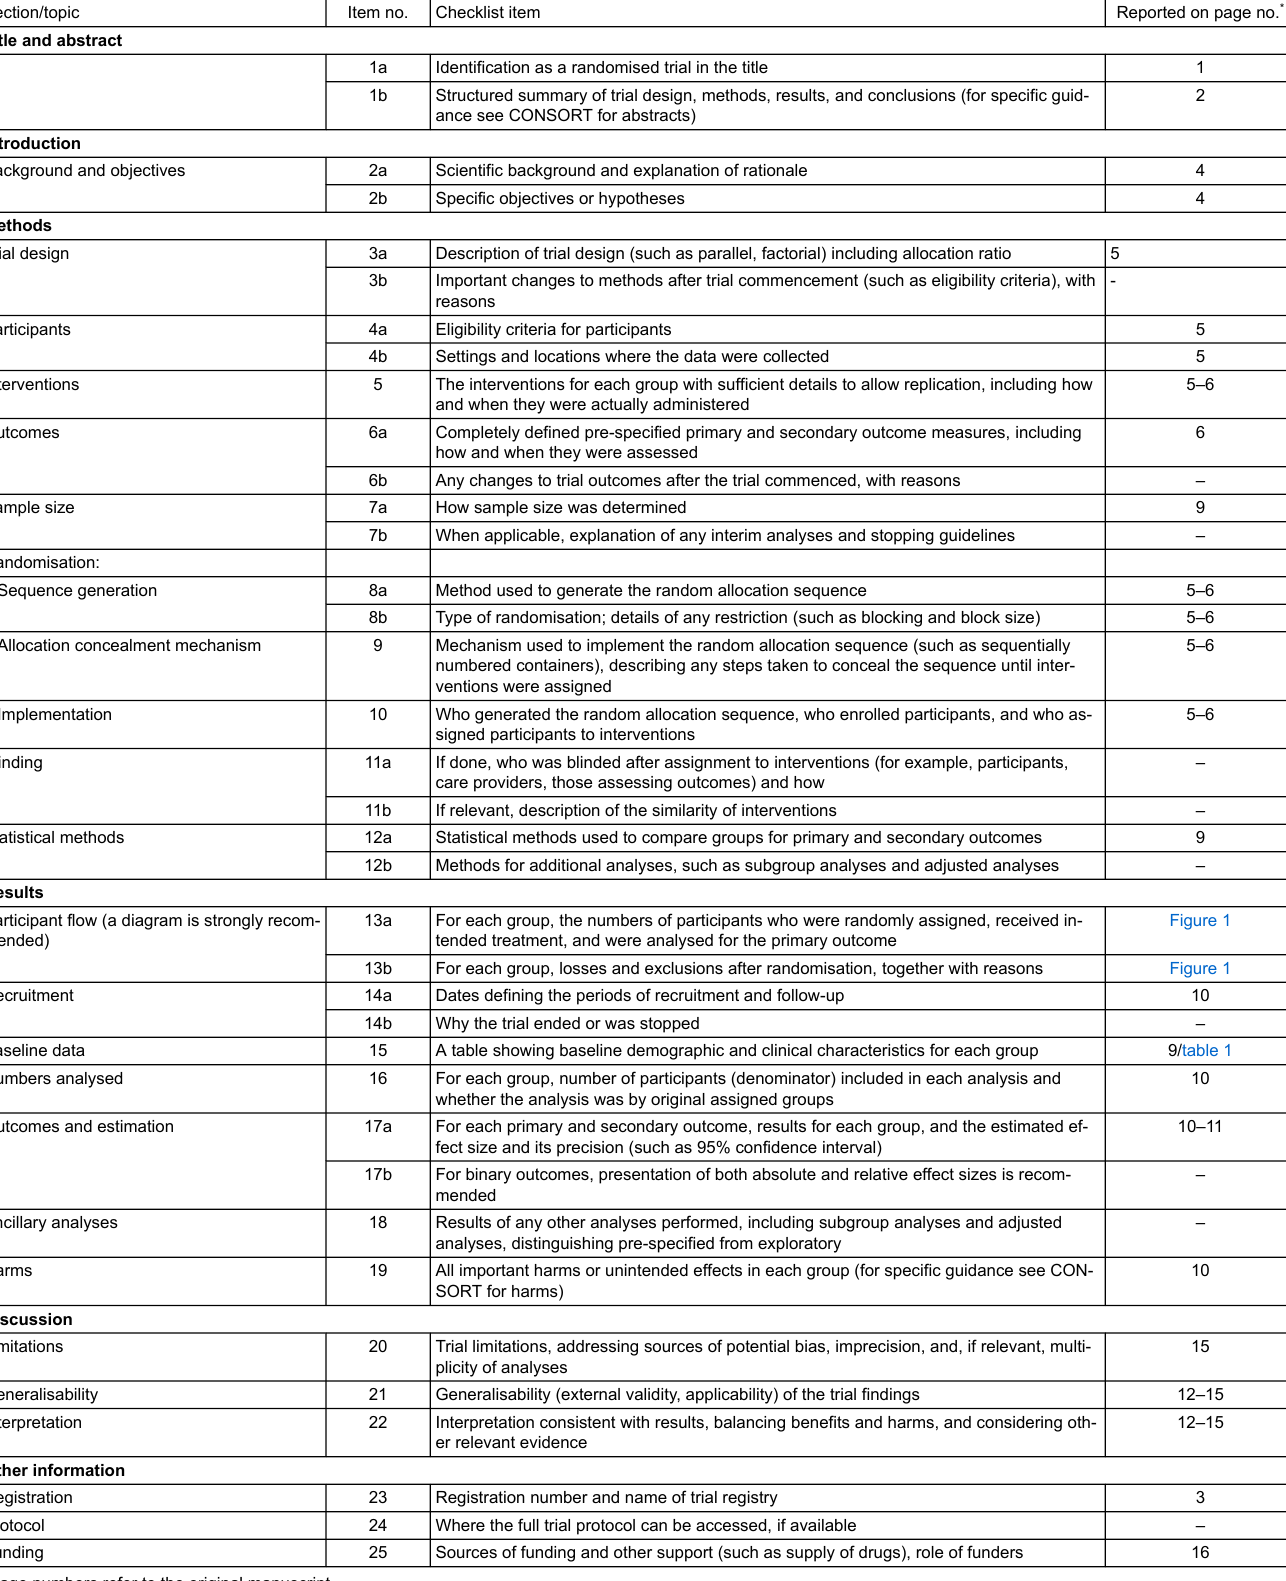
Table S1: CONSORT 2010 checklist of information to include when reporting a randomised trial